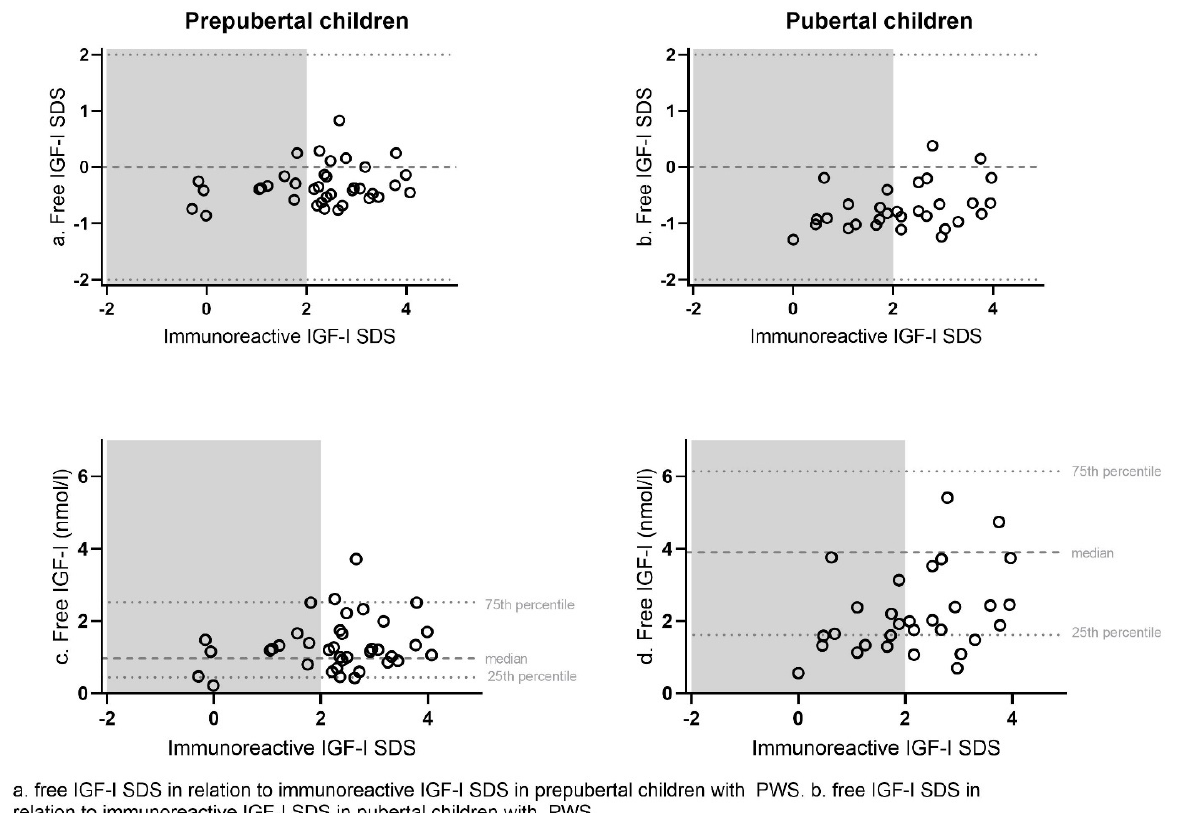
Figure 1. Free IGF-I and free IGF-I SDS in relation to immunoreactive IGF-I SDS in prepubertal and pubertal children with PWS.